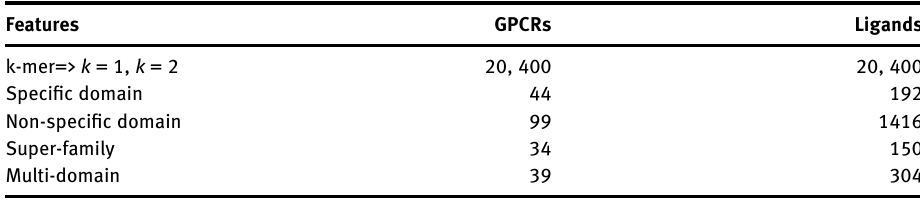
Table  : Extracted feature groups for GPCRs and ligands. Features